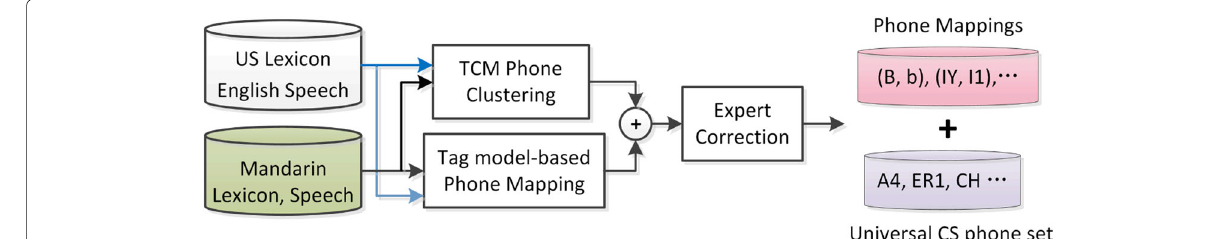
Fig. 1 The proposed E2M mix-language phone mapping